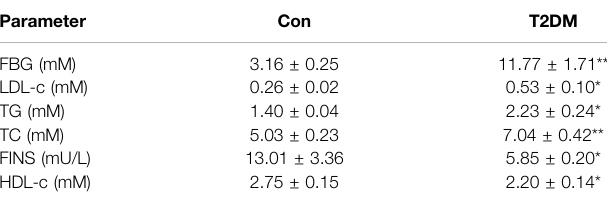
TABLE 1 | Serum biochemical parameters of CON and T2DM C57BL/6J